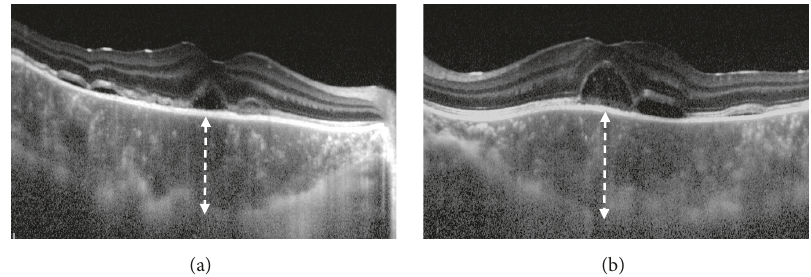
Figure2:Horizontalenhanceddepthopticalcoherencetomographic(EDI-OCT)imagesattheinitialexaminationshowingmarkedchoroidal thickening and subfoveal detachment with subretinal septa in both eyes. (a) The right eye. (b) The left eye. The choroidal thickness at the subfovea was 578 𝜇 m in the right eye and 642 𝜇 m in the left